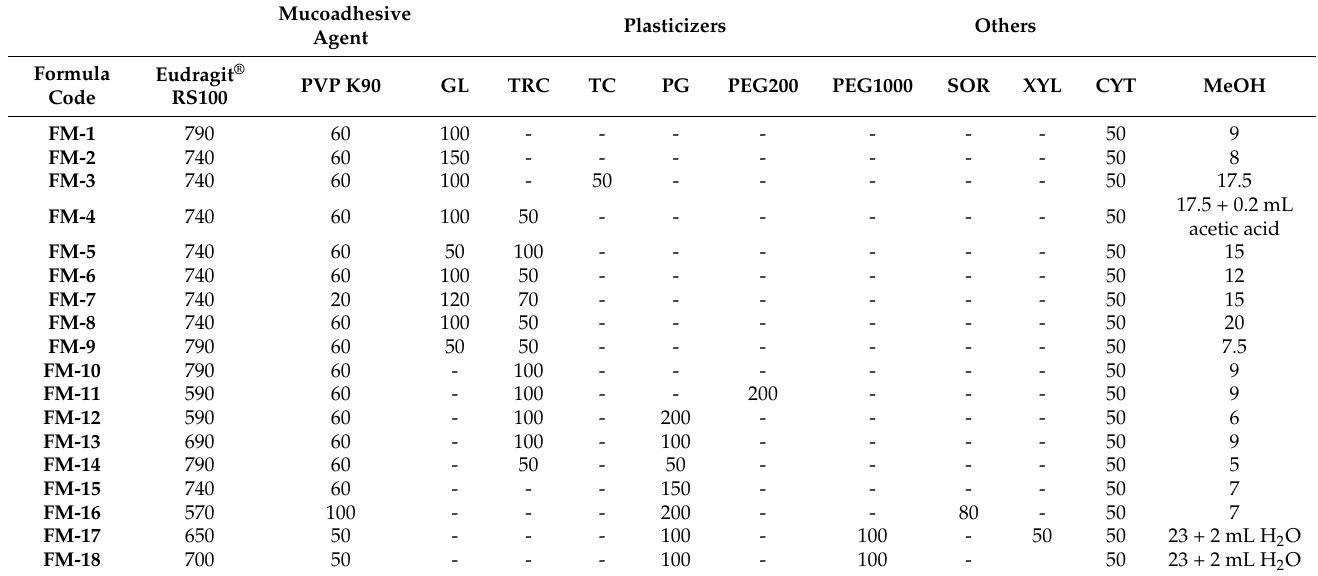
Table 2. Weight composition (mg) of CYT-loaded buccal films prepared by solvent casting method by using methanol (mL) as